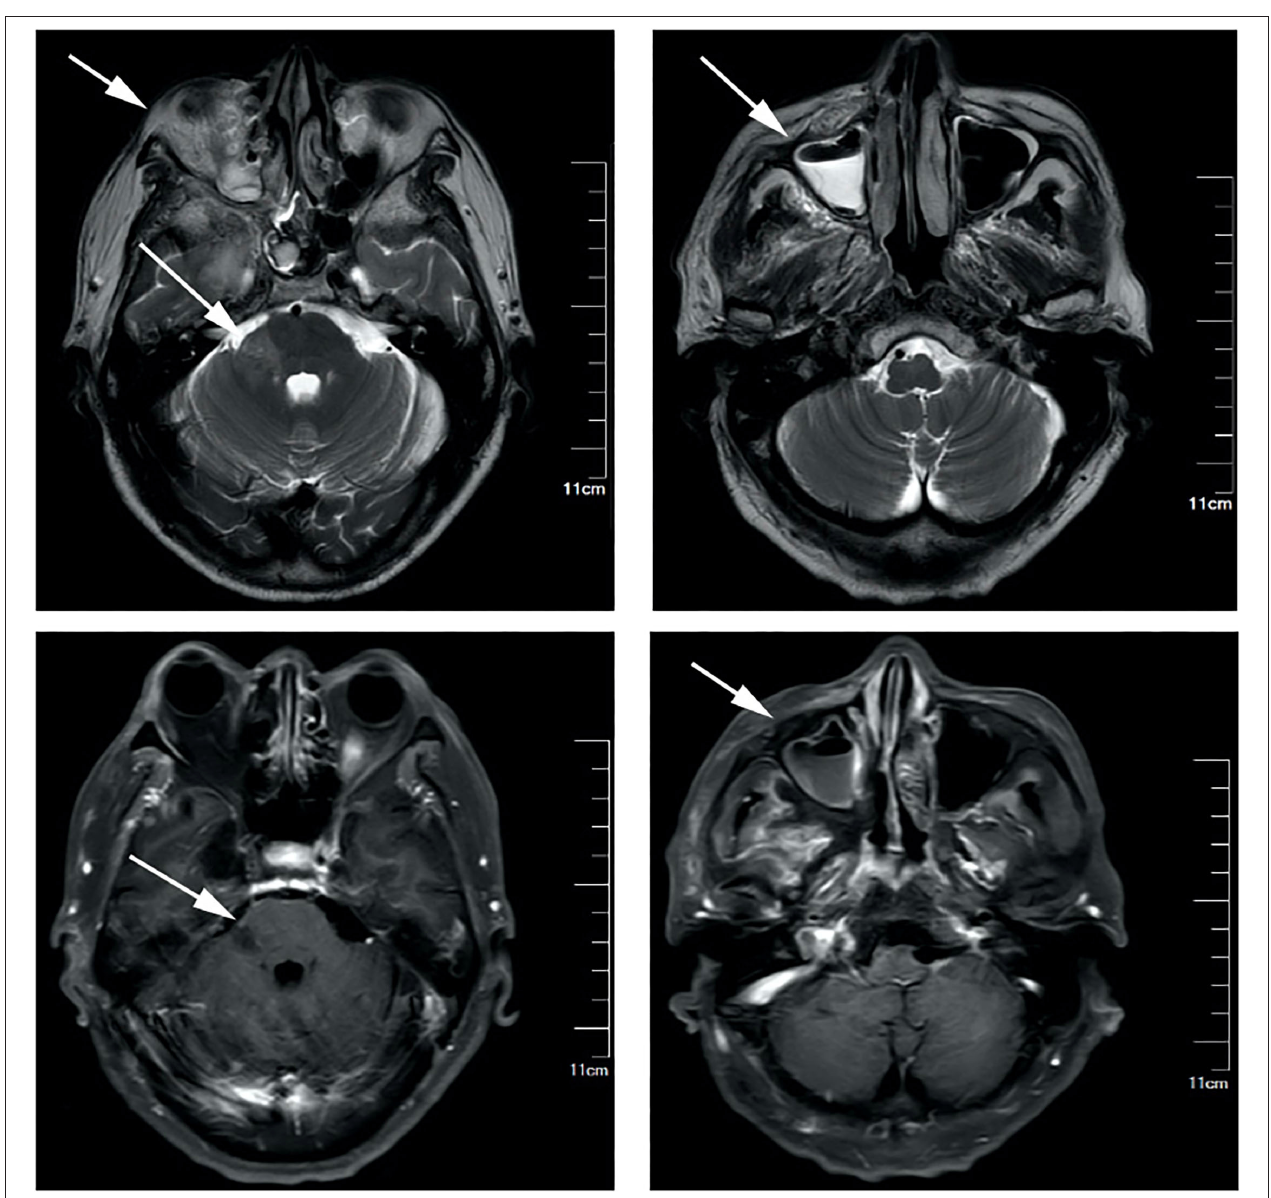
FIGURE 1 | Gadolinium-enhanced brain magnetic resonance imaging (MRI) revealed bilateral pansinusitis and multiple lesions scattered in the right cerebral hemisphere and right pons, showing hypointensity on T1-weighted images, and hyperintensity on T2-weighted and fluid attenuated inversion recovery (FLAIR) images, without contrast